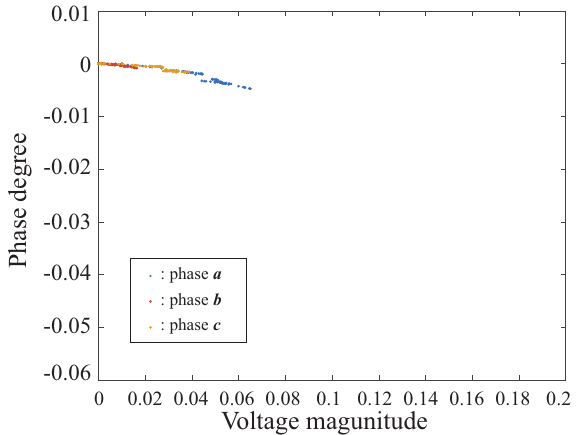
Figure 20. A few phase unbalances in the case of penetrated RES.